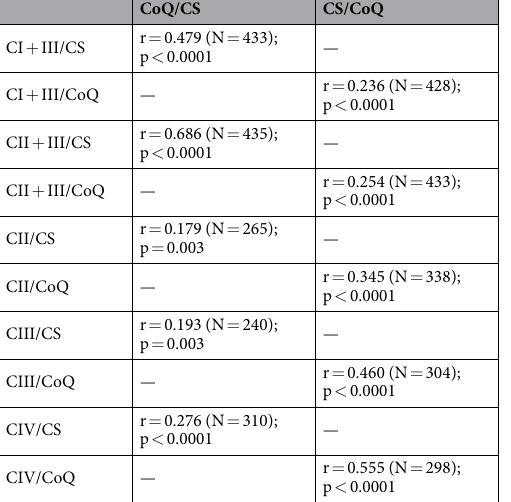
Table 3. Correlation data (Pearson test) among muscle CoQ, CS and MRC activities normalized to either CS activity (middle column) or CoQ content (right